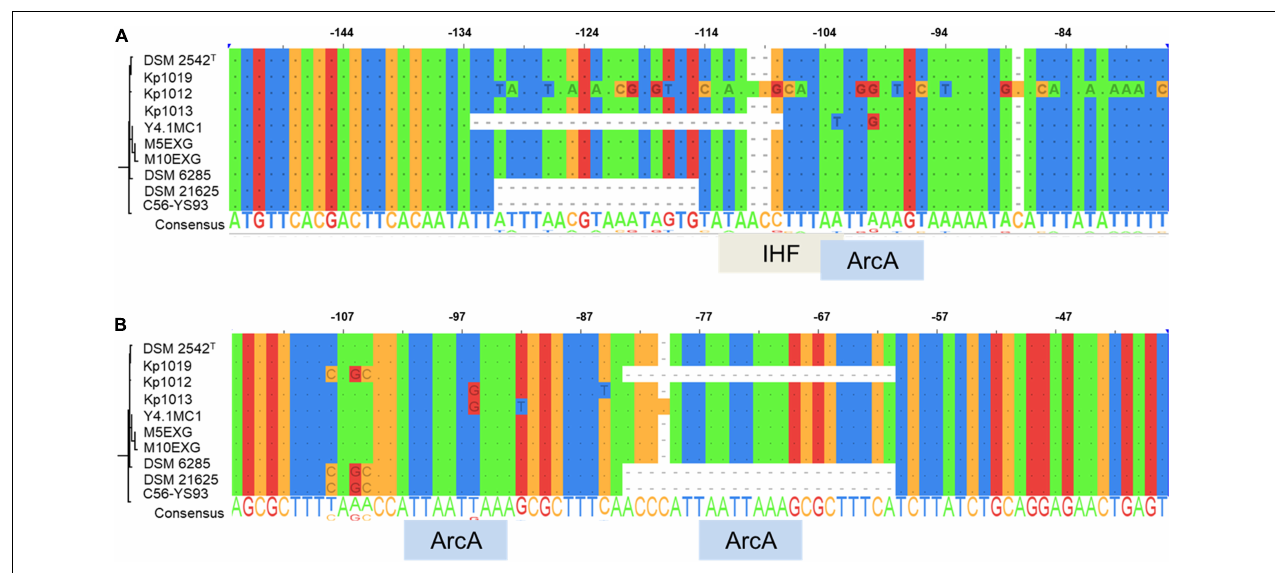
FIGURE 4 | Alignment of PCR amplified deletions adjacent to the cooC reading frame among ten P. thermoglucosidasius strains characterized for hydrogenogenesis. (A) Indel 1 upstream of cooC and associated transcription factor binding sites (TFBs), (B) Indel 2 between cooC and cooS and associated TFBs. ArcA and IHF are the aerobic respiration control protein and integration host factor,